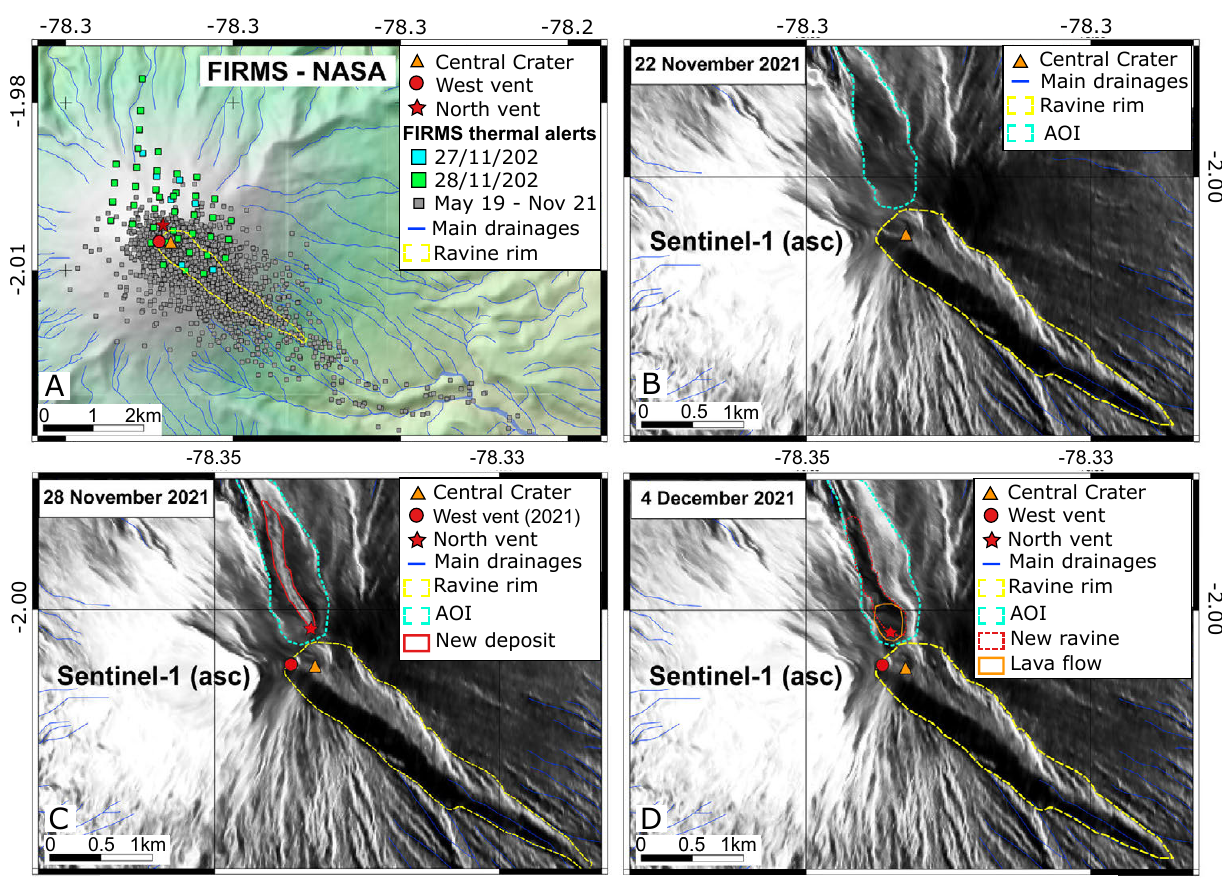
Figure 6: [A] Location of thermal anomalies (FIRMS) around the summit of Sangay since May 2019. The thermal anomalies are clearly seen to the north beginning on 27 November, 2021; [B] Sentinel-1 image ( MOUNTS ) for 22 November, 2021 showing no morphological changes; [C] Hot deposits on the northern flank of the volcano; [D] trace of a landslide visible in black to the north (red dotted line). The hot deposits have been completely removed and the advance of a lava flow is marked following the trace on the Sentinel-2 image of 2 December, 2021 (orange